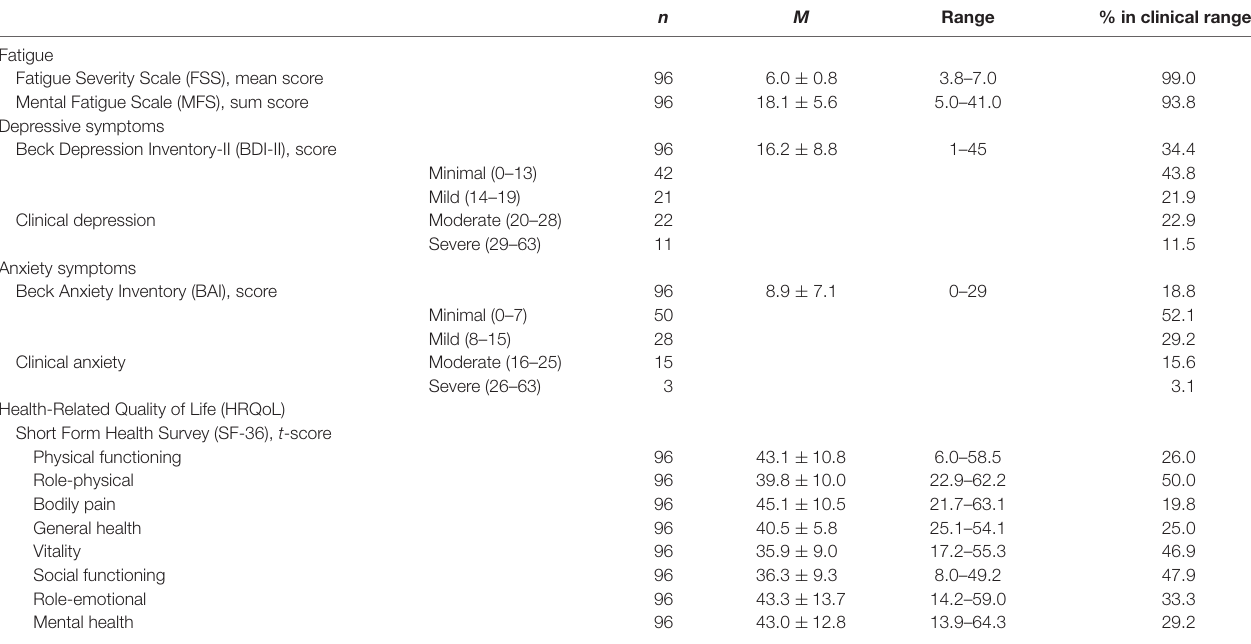
TABLE 2 | Mean score and percentage of patients with responses in the clinical range on self-assessment questionnaires. n M Range % in clinical